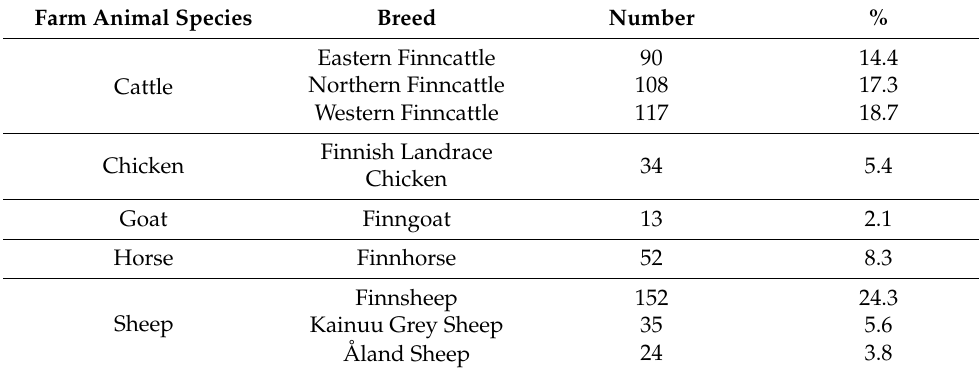
Table 1. Number of farm animal breeds kept by the respondents.